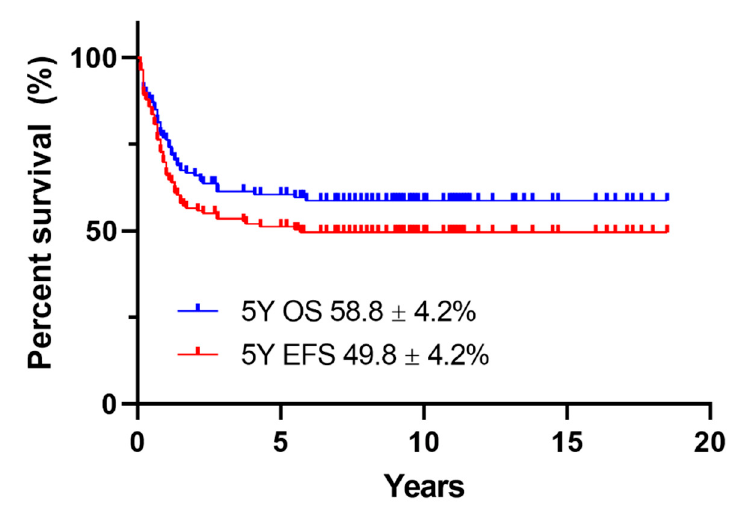
Figure 3. The 5-year OS and EFS rates of patients. OS, overall survival; EFS, event-free survival.